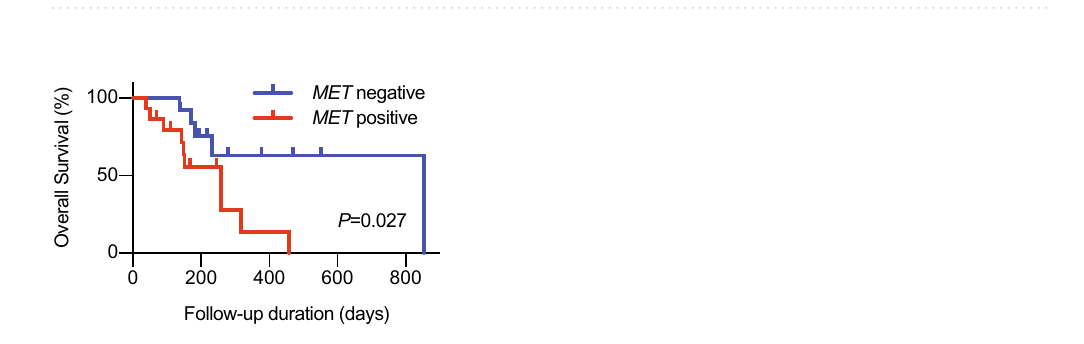
Table 1. Patient demographics and clinical characteristics.